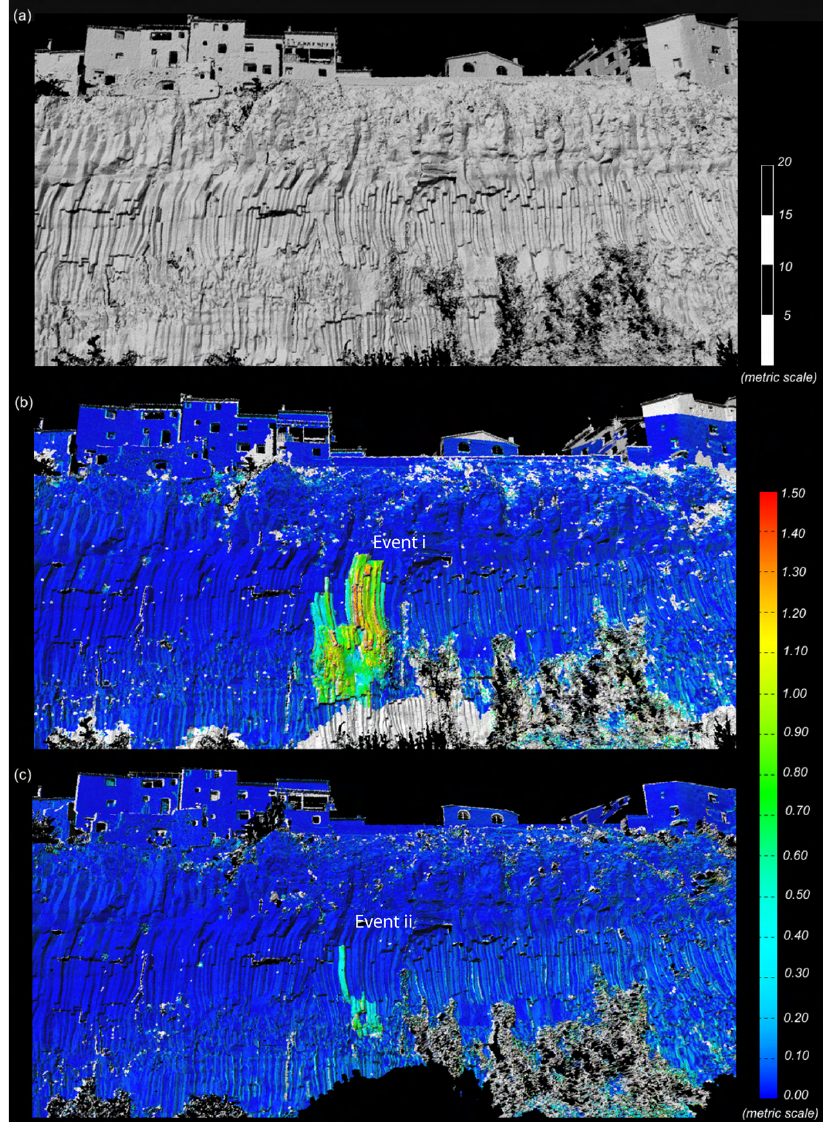
Fig. 6. (a) TIN surface of a part of the rock face where events i and ii took place; (b) comparison of the March and April 2007 datasets; (c) comparison of the October 2007 and January 2008 datasets. Each point is colour-coded according to the changes during the period of comparison. Colour scale indicates positive differences along the Y direction, e.g. rockfalls. Note that event ii is in the same area as event